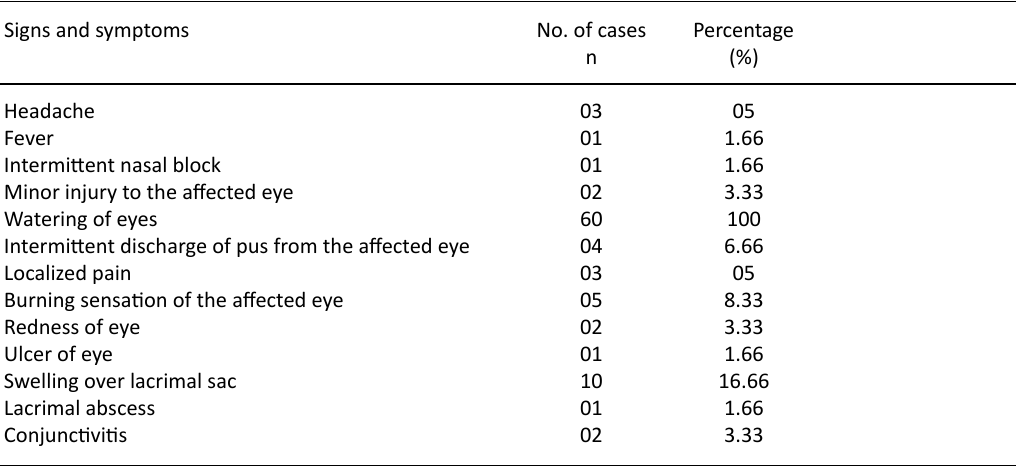
Table 2. Distribution of chronic dacryocystitis cases according to Clinical signs and symptoms (n = 60) Signs and symptoms